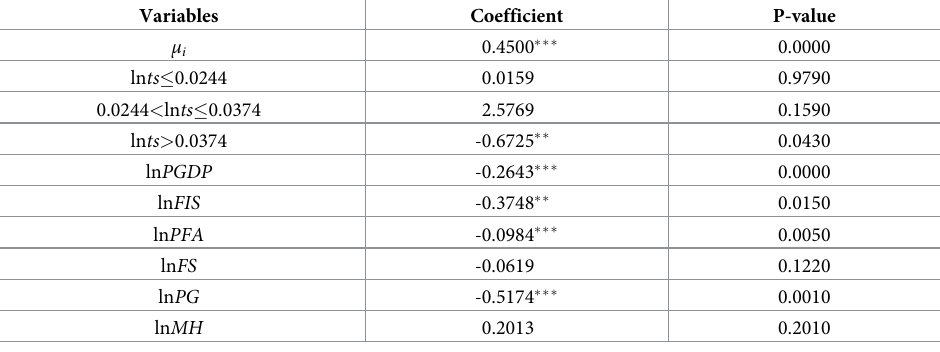
Table 4. Regression estimation results of panel threshold